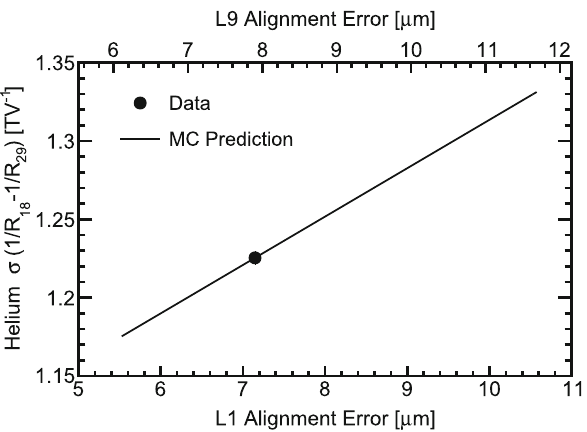
(cid:4) (cid:23) ε 0 Atrackfittingisperformedon i